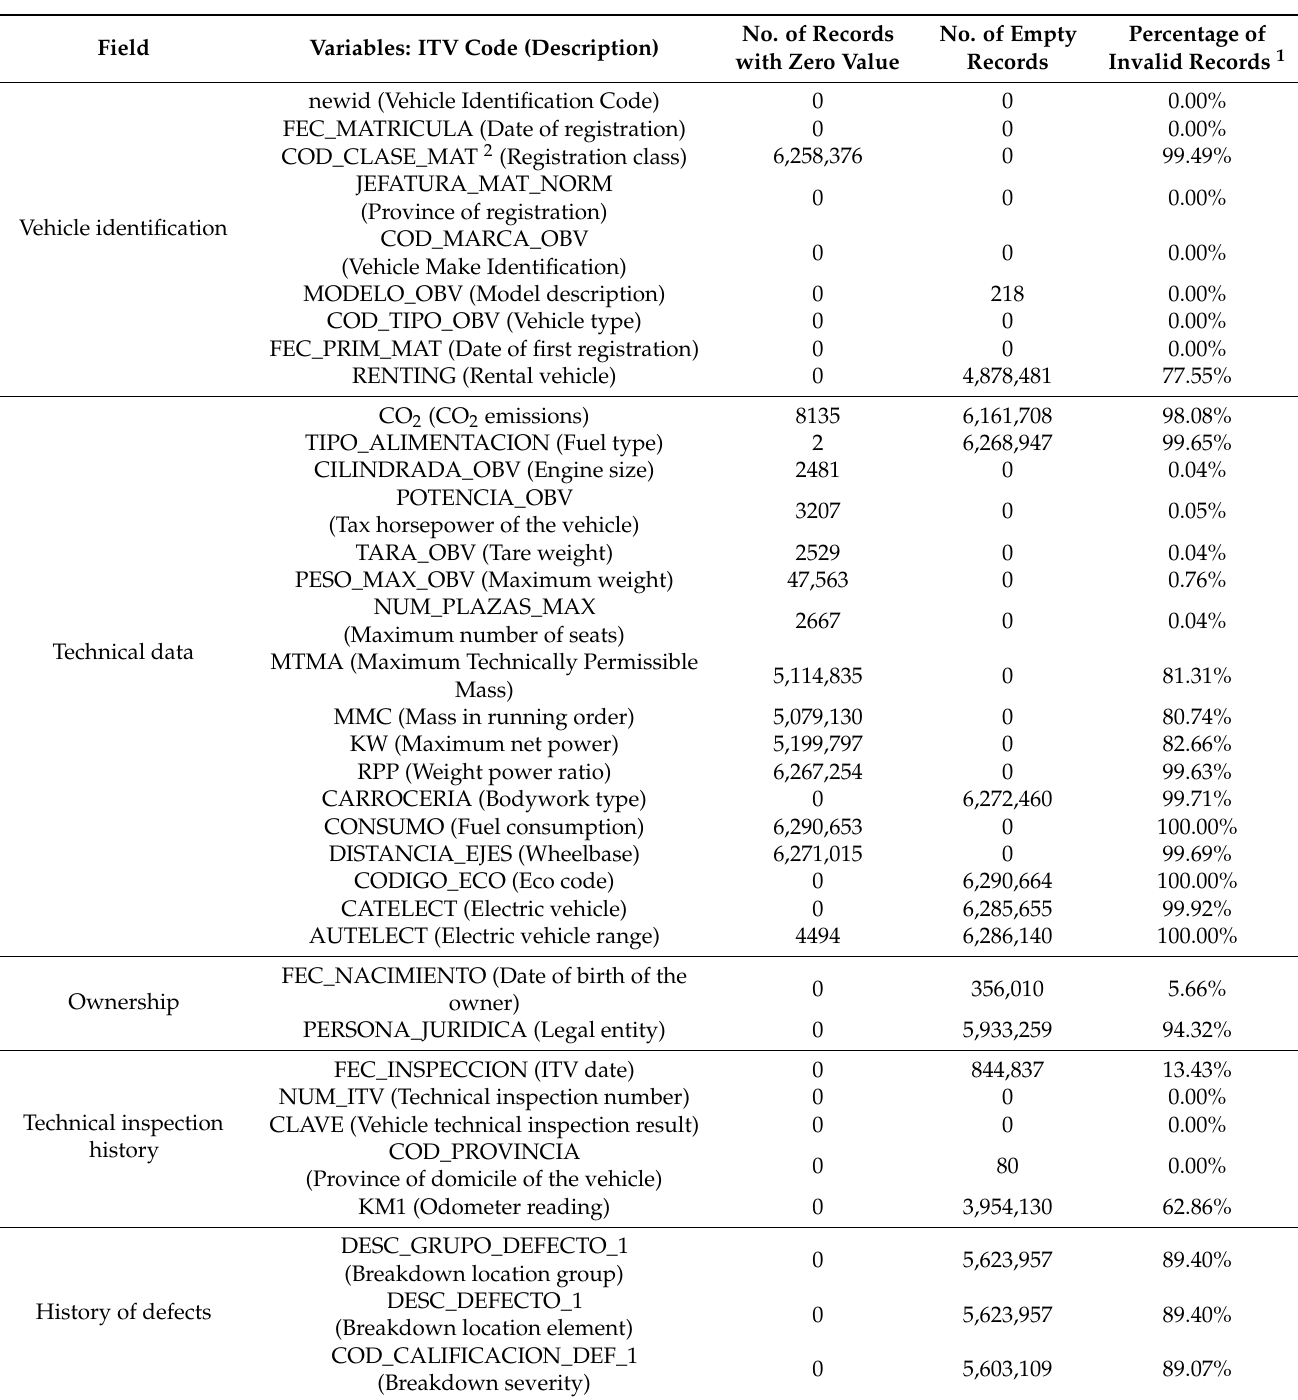
Table 1. Variables of the data provided by the